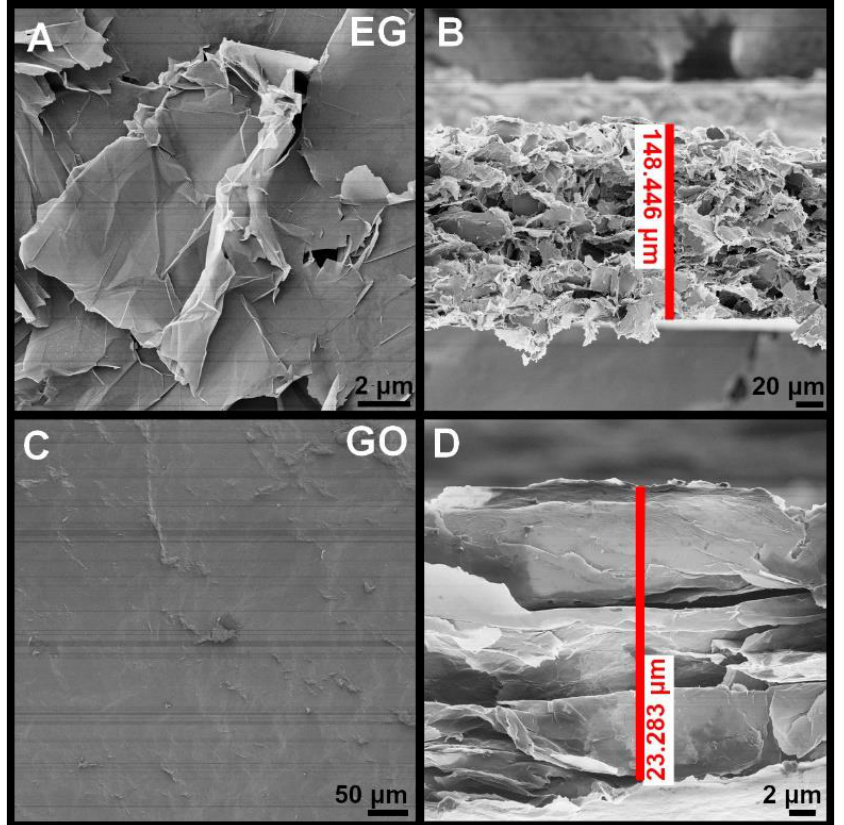
Figure 2. SEM images of the ( A ) surface and ( B ) cross-section of the EG paper, and ( C ) surface and ( D ) cross-section of the GO paper.